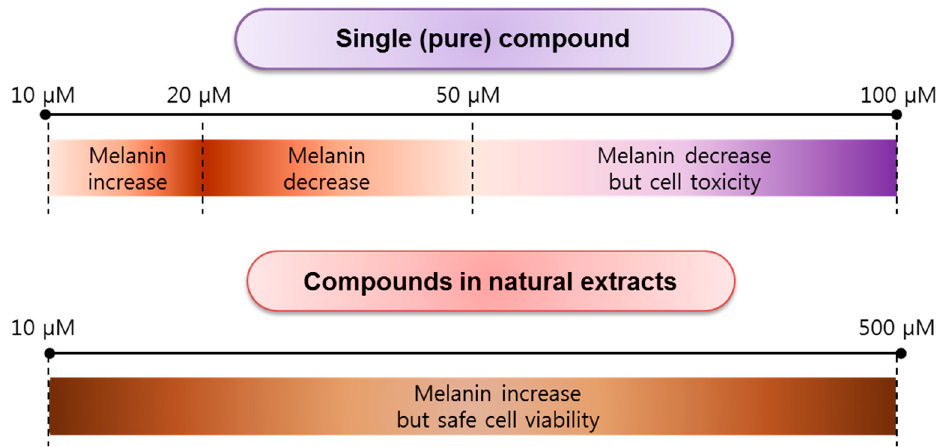
Figure 3. Concentration dependency of pure quercetin and natural quercetin in cell viability and anti-melanogenesis.